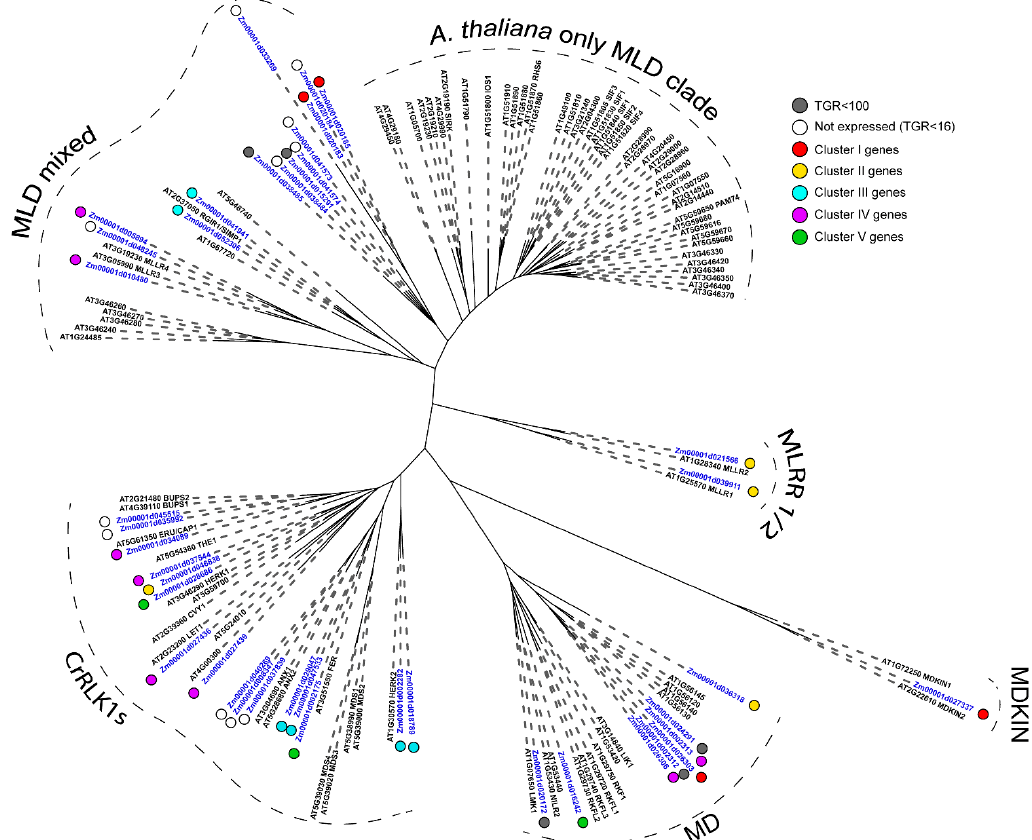
Figure 4. Phylogenetic dendrogram of malectin (PF11721) and malectin-like (PF12819) family mem- bers of A. thaliana (gene names are given in black font) and Z. mays (blue font). The colored dots next to Z. mays genes denote the character of expression: white—genes with no expression (TGR value less than 16 in all samples); gray—genes with a TGR value less than 100 in all samples; red—genes from cluster I, expression decreased from meristem and root cap zones to late elongation; yellow— genes from cluster II, expression peaks in the early elongation zone; blue—genes from cluster III, high expression from early to late elongation; purple—genes from cluster IV, expression increased in the root cap and also increased from meristem zone to late elongation; green—genes from cluster V, highest expression in the late elongation zone. Only branches with ultrafast bootstrap support values greater than 90 are shown. Jacalin-related lectins, which are mostly mannose-specific proteins with a localiza- tion in the cytoplasm or nucleus [13], have a monocot-specific combination of the lectin domain with dirigent or kinase domain [4,13]. In maize, a combination of lectin domain with the dirigent domain (PF03018) or kinase domain (PF00069) was also detected (Table